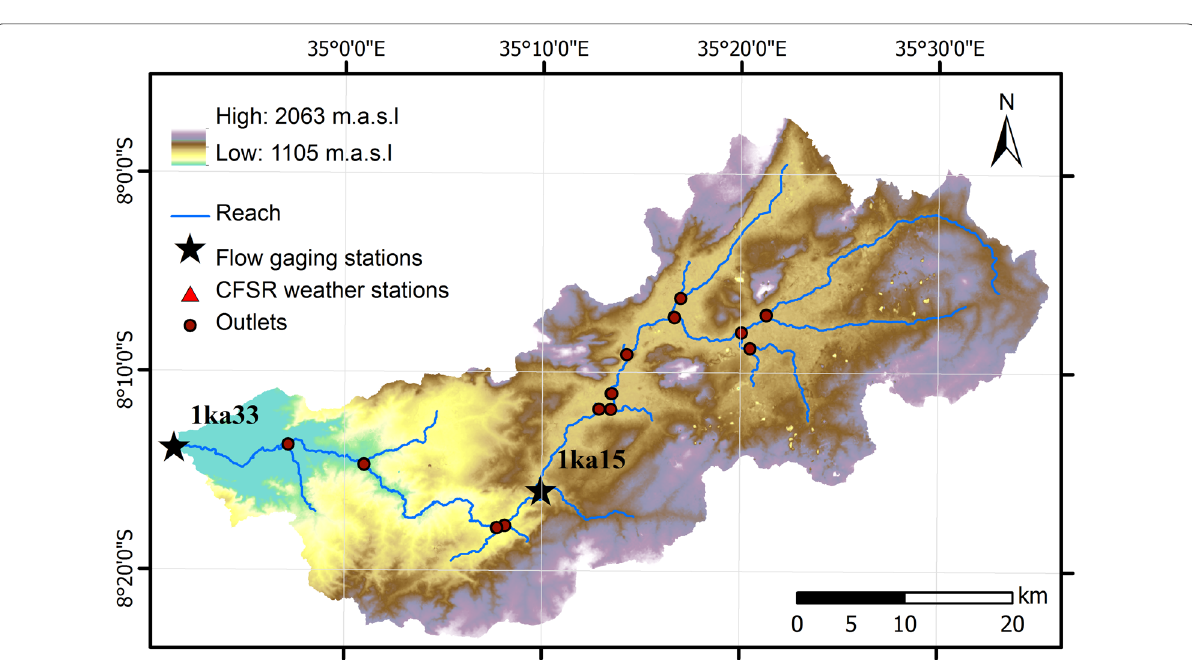
Fig. 2 DEM of Ndembera river catchment. The watershed was delineated using the 1ka33 gaging station as the most downstream